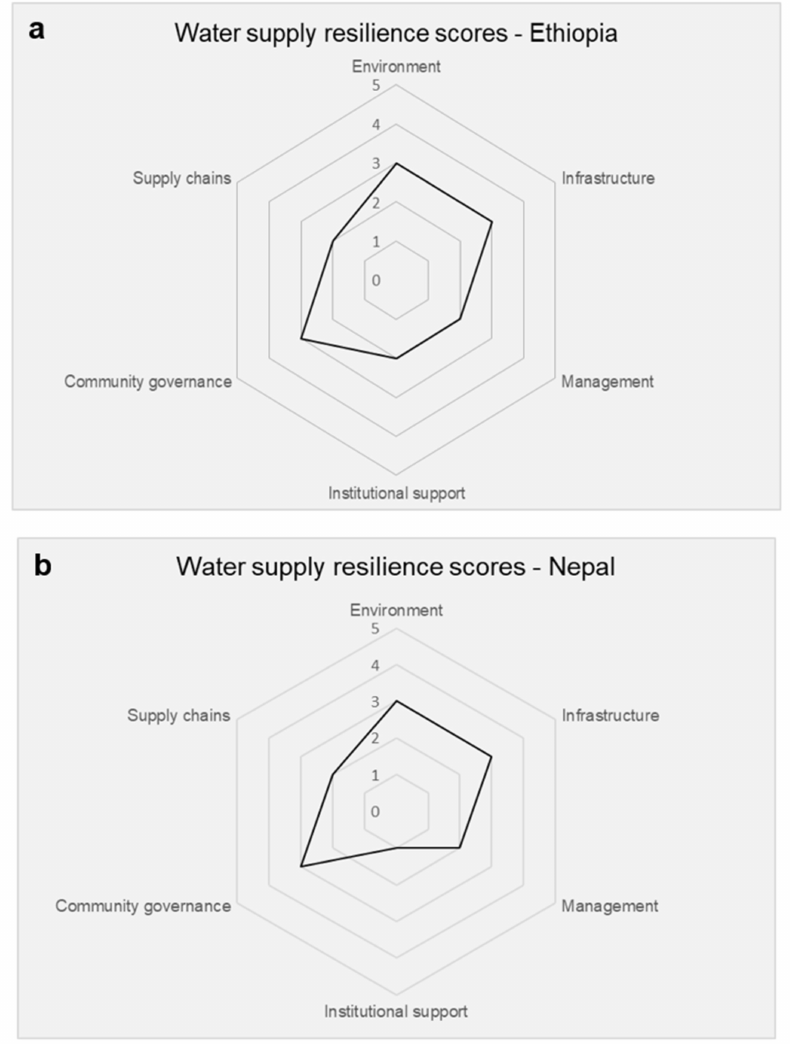
Figure 2. Median resilience scores for water supplies in ( a ) Ethiopia and ( b )